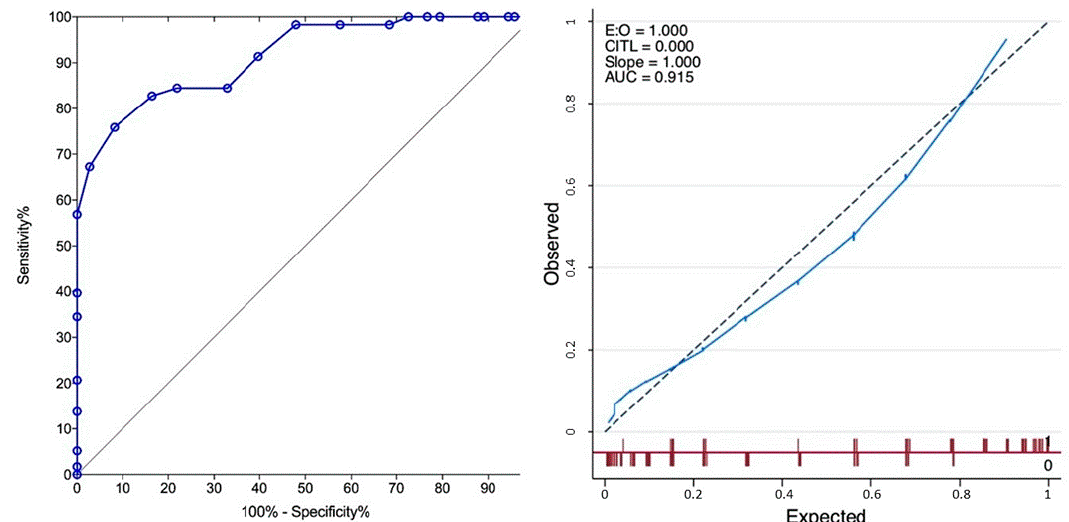
Figure 6. ROC curves of the Bladder Complexity Checklist Sum (BCCS) and the corresponding calibration curve showing similar discrimination and calibration performances compared to the regression model.